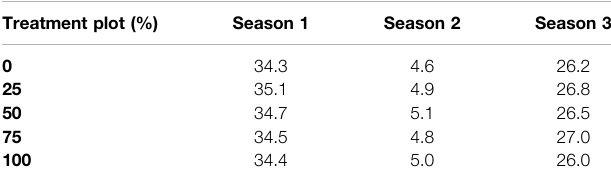
TABLE 2 | Soil moisture contents (%) within the various thinning plots and season in the savanna of southern Ethiopia. Treatment plot